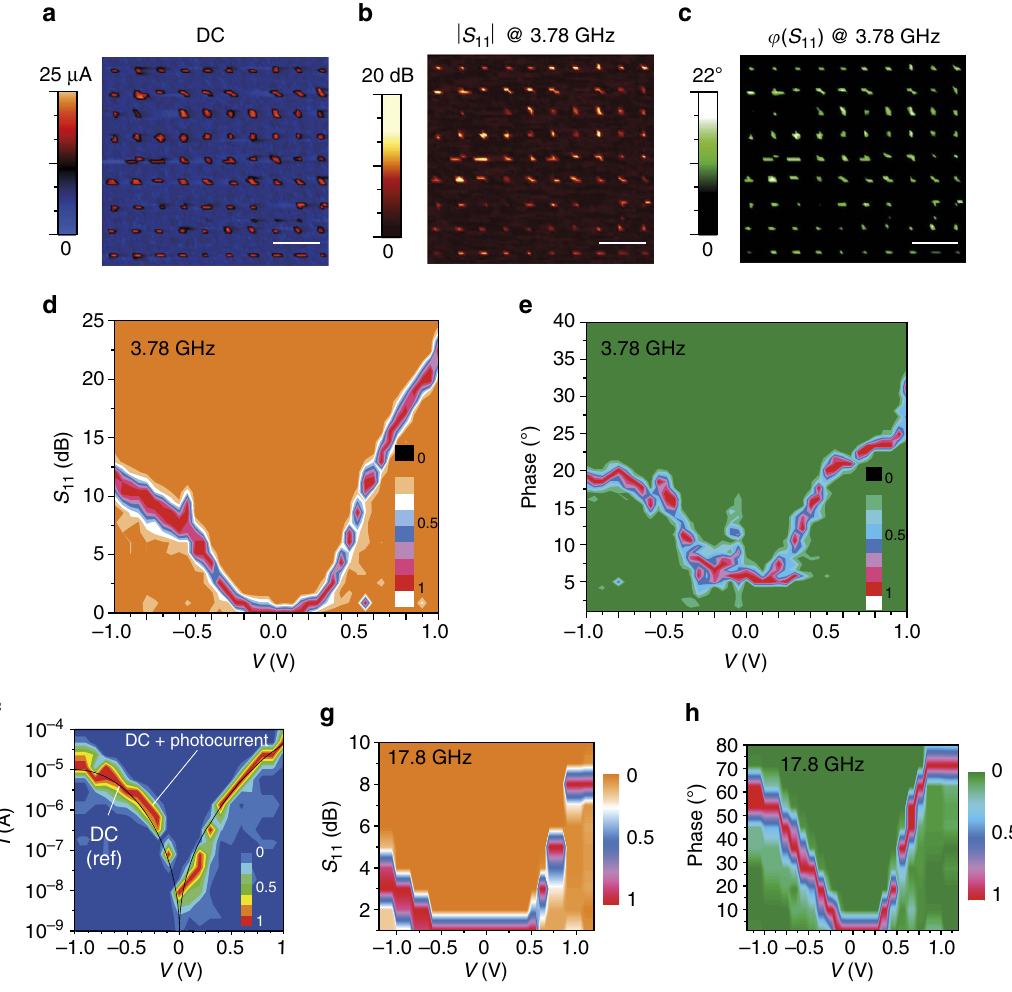
Figure 3 | Demonstration of a molecular rectifier at 3.78 and 17.8GHz. ( a – c ) iSMM images at 0.8V d.c. and 3.78GHz measured simultaneously by the amperometer (Resiscope) for the d.c. ( a ) and vectorial network analyser (VNA) for amplitude ( b ) and phase ( c ) S 11 parameters. Scale bars, 500nm. ( d , e ) 2D | S 11 | histogram (normalized to one) versus tip bias ( V ) and j ( S 11 )– V 2D histograms (normalized to one) generated from one hundred molecular rectifier junctions. The voltage step was 0.05V and the contour plot generated automatically (Originlab). The applied load was 18nN. ( f ) 2D d.c. I–V histogram from one hundred of ferrocenyl undecanethiol gold nanojunctions with a 17.8GHz RF input signal. The d.c. reference current (solid line) when no RF input signal was added is shown for comparison. It was obtained from the average I–V from a 2D histogram, without RF power. The voltage step was 0.1V and the contour plot generated automatically (Originlab). ( g , h ) 2D | S 11 | versus voltage curve from one hundred of ferrocenyl undecanethiol gold nanojunctions at 17.8GHz and related j ( S 11 ) versus V curve. The voltage step was 0.1V and the contour plot generated automatically